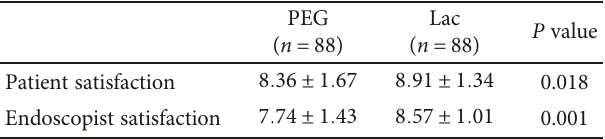
Table 6: The degrees of satisfaction evaluated by patients and endoscopist.